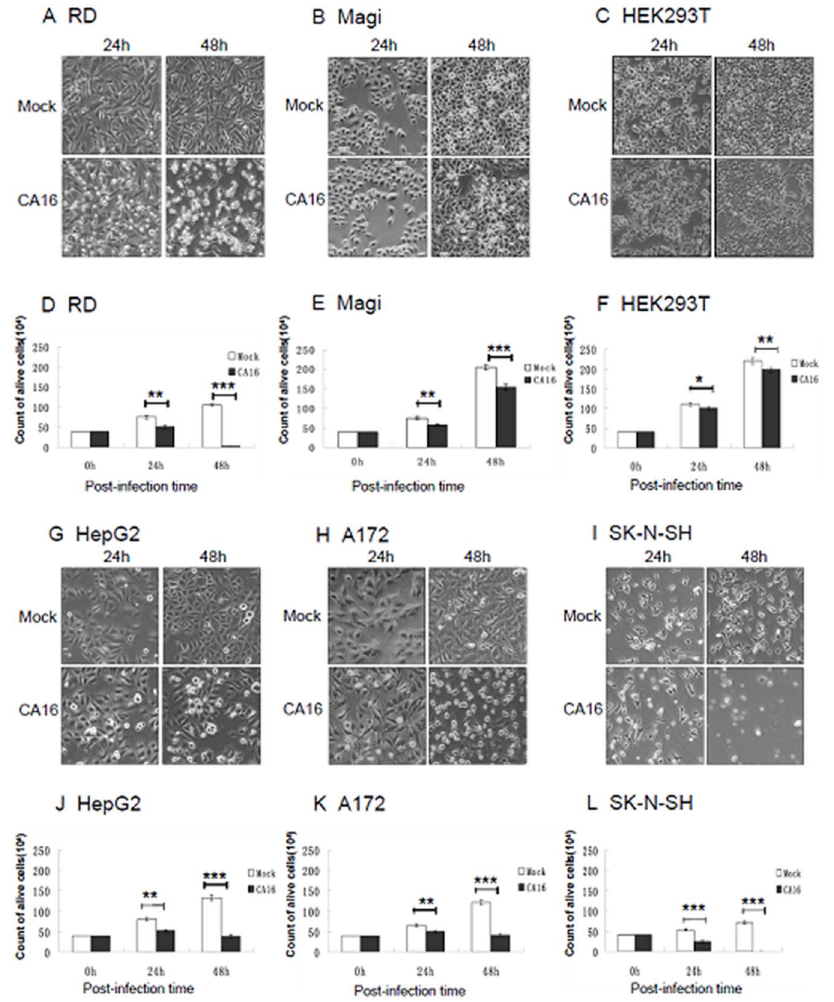
Figure 1. CA16 induces CPEs in both neural and non-neural cells. Different cell lines were inoculated with CA16 SHZH05 virus at the MOI of 0.2 or DMEM as a negative control. At 24 h and 48 h post-infection, cells were imaged via light microscopy, stained with Trypan Blue and counted. Representative images of (A) RD, (B) Magi, (C) HEK293T, (G) HepG2, (H) A172 and (I) SK-N-SH cell lines are shown of three individual experiments performed for each cell line. Counts of live (D) RD, (E) Magi, (F) HEK293T, (J) HepG2, (K) A172 and (L) SK-N-SH cells (n=3) were statistically analyzed for differences between infected and control groups. * P , 0.05, ** P , 0.01, *** P , 0.001.